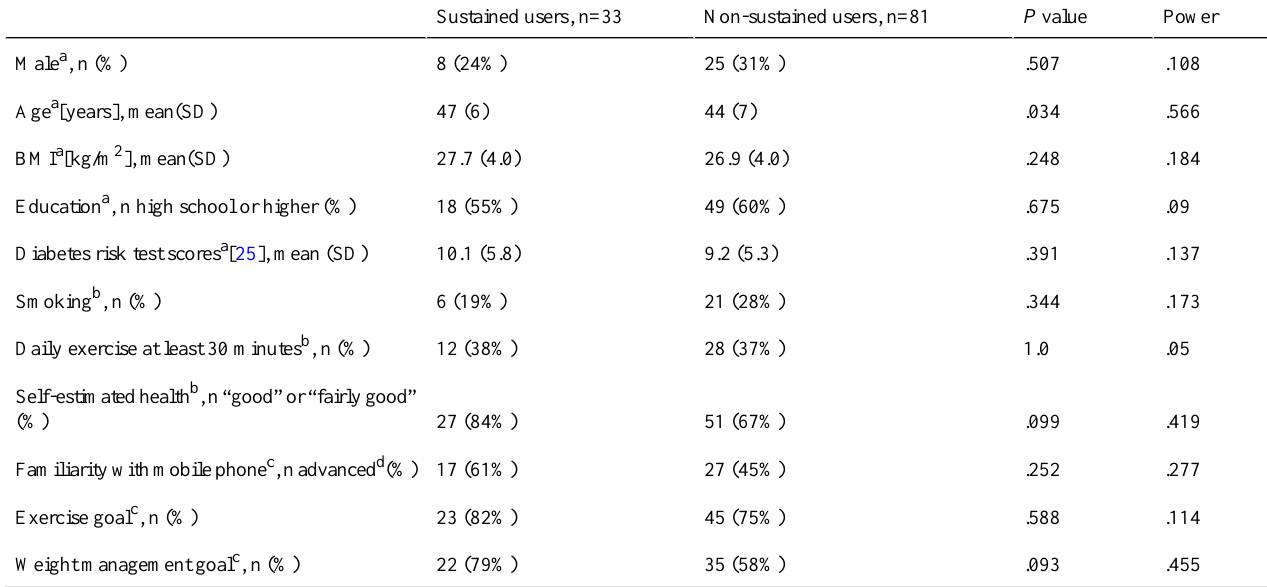
Table 4. Comparison of baseline demographics and baseline health and technology questionnaire responses between sustained users and non-sustained users as mean (SD) or frequency